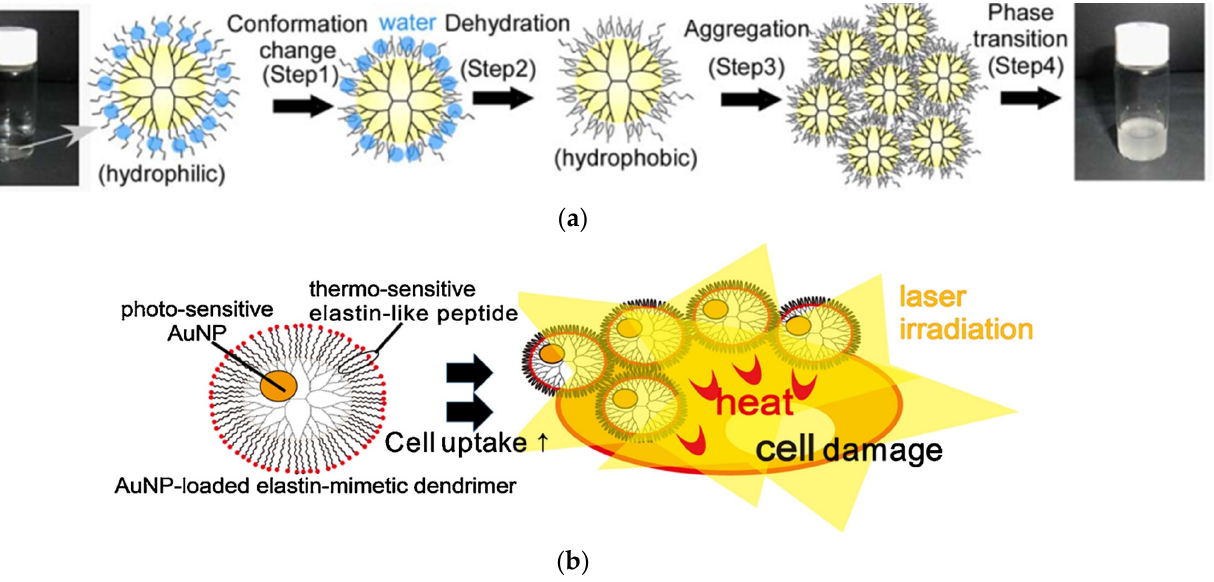
Figure 5. ( a ) Possible mechanism of phase transition in elastin mimetic dendrimers. Reproduced with permission from [126]. Copyright: Wiley Periodicals, Inc. ( b ) Dual stimuli: photo and thermo- sensitive dendrimer derivatives. Reproduced with permission from [127]. Copyright: Elsevier Ltd. Table 1. The involvement of dendritic polymers in Collagen and Elastin biomimicry. Dendritic Polymer